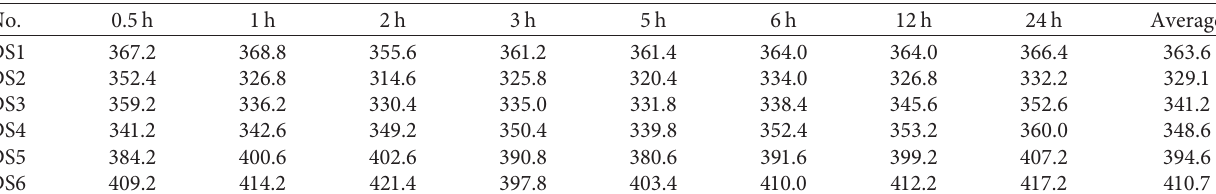
Figure 5: Test result of evaluation indexes of the compatibility between straw fibers and cement-based materials. Table 5: Mass water absorption of the straw fiber within 24h